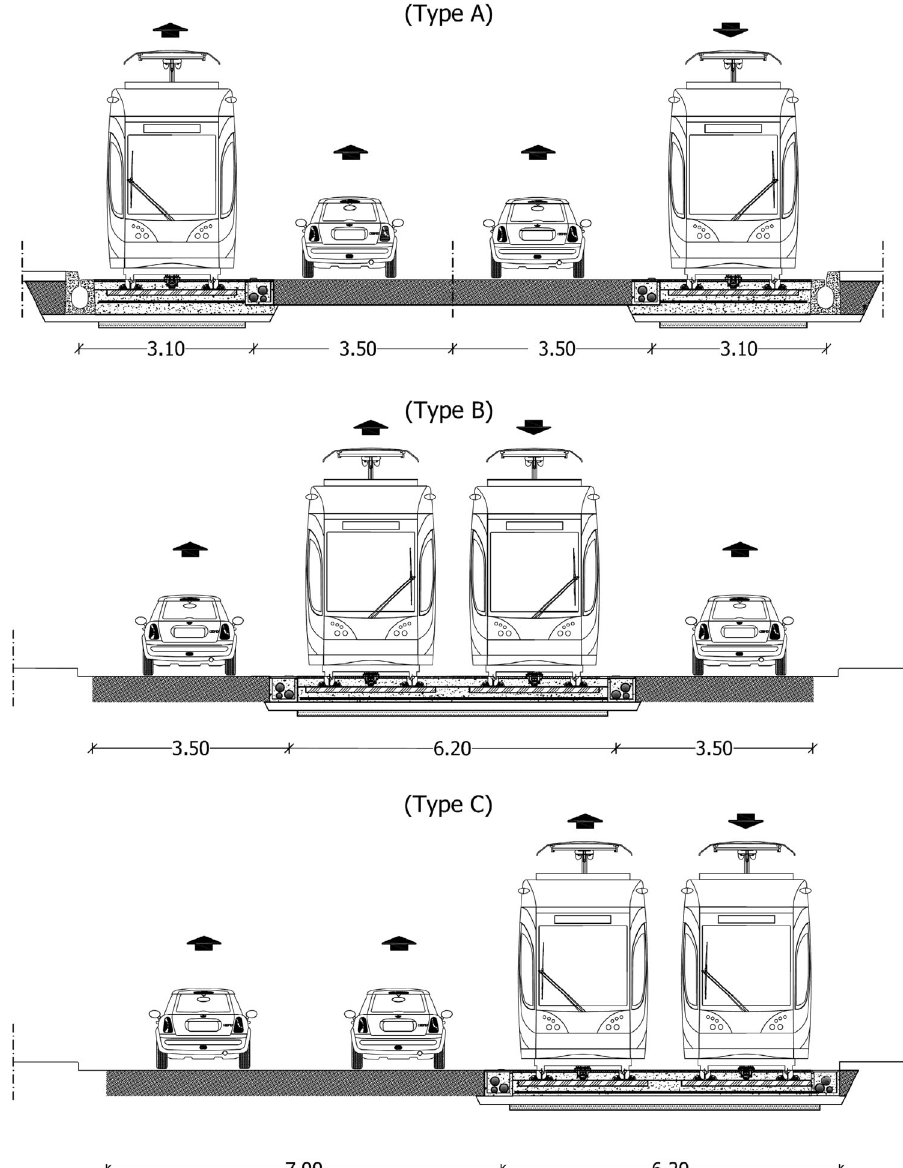
Fig. 6 Road section and railway track layouts (dimension expressed